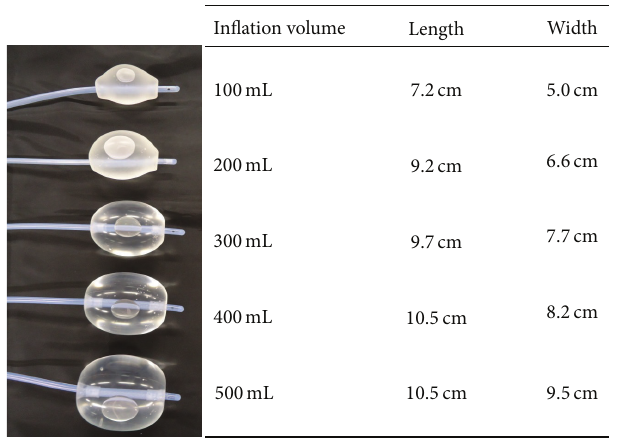
Figure 4: The size of each balloon (inflated to a volume of 100–500